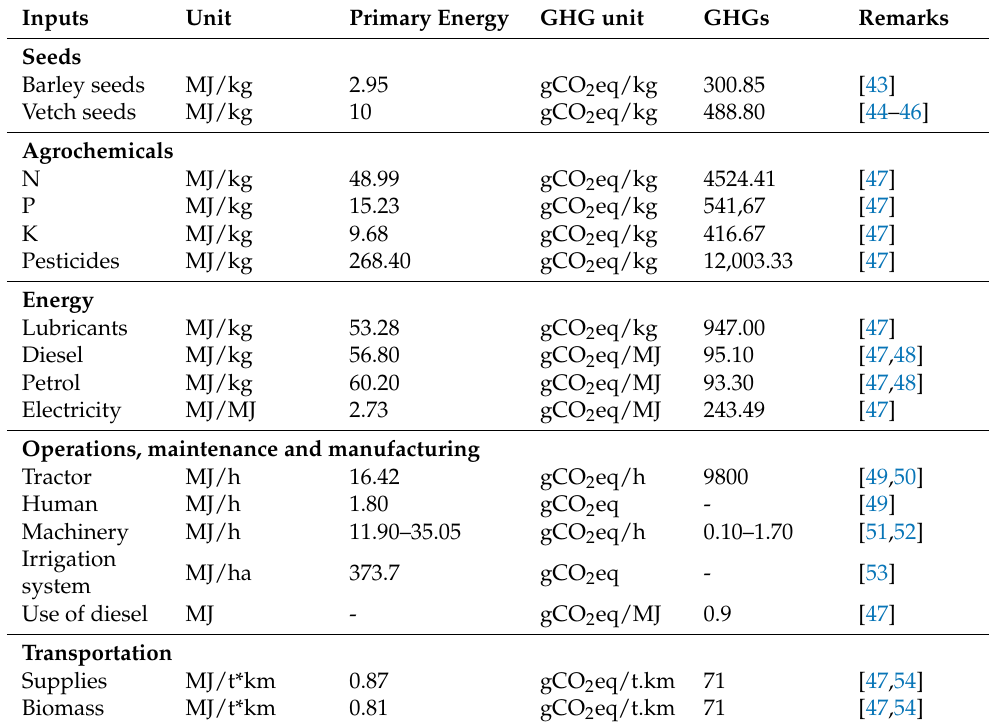
Table 1. Inventory analysis for primary energy usage and GHG emissions.